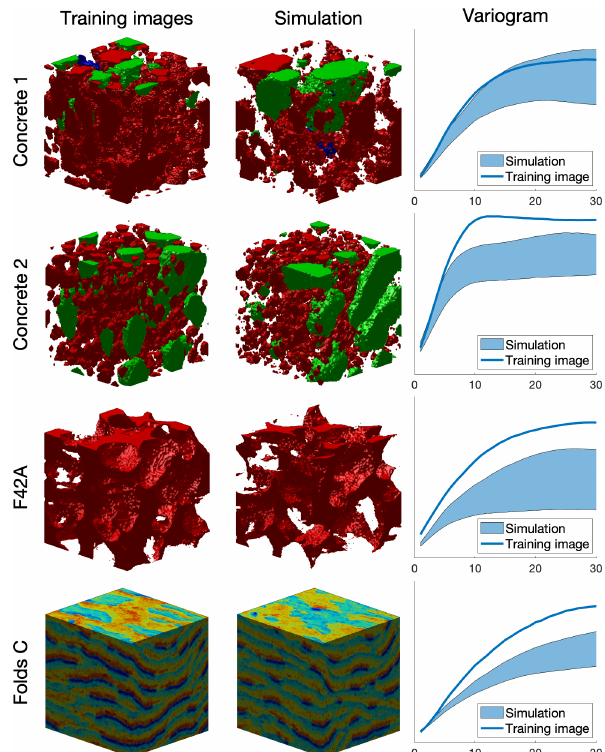
Figure A3. Examples of 3D simulation results. Parameters available in Table